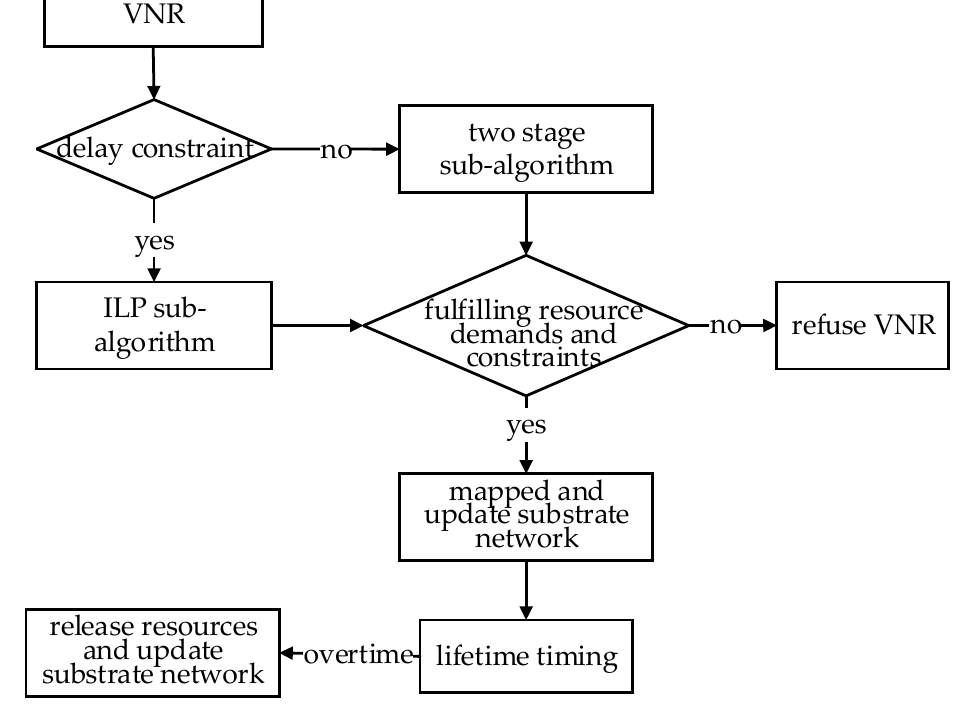
Figure 1. Flow Chart of VNE Algorithm.